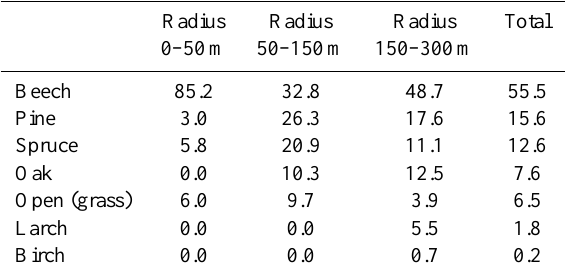
Table 1. Fractions of different tree stands in percent within the foot- print of the CRS. The total represents a distance-weighted average with an exponential decay towards more distant areas (approximat- ing the exponential distance weighting from Zreda et al.,